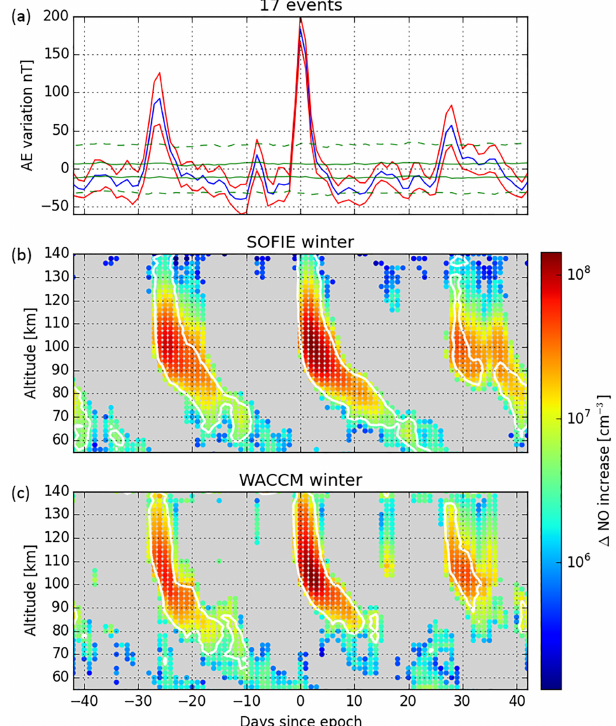
Figure 10. Epoch analysis performed every 2km on winter hemi- spheric data in SOFIE (b) and WACCM (c) . Dates are selected when the AE variation exceeds 2 σ , resulting in 17 events. (a) Blue and red lines represent the mean and standard errors of the AE variations, while full and dashed green lines represent 1 σ and 2 σ significance levels. (b, c) NO number density enhancements with the white con- tour line and the grey background representing a 1 σ significance level and non-significant or negative NO variations, respectively.